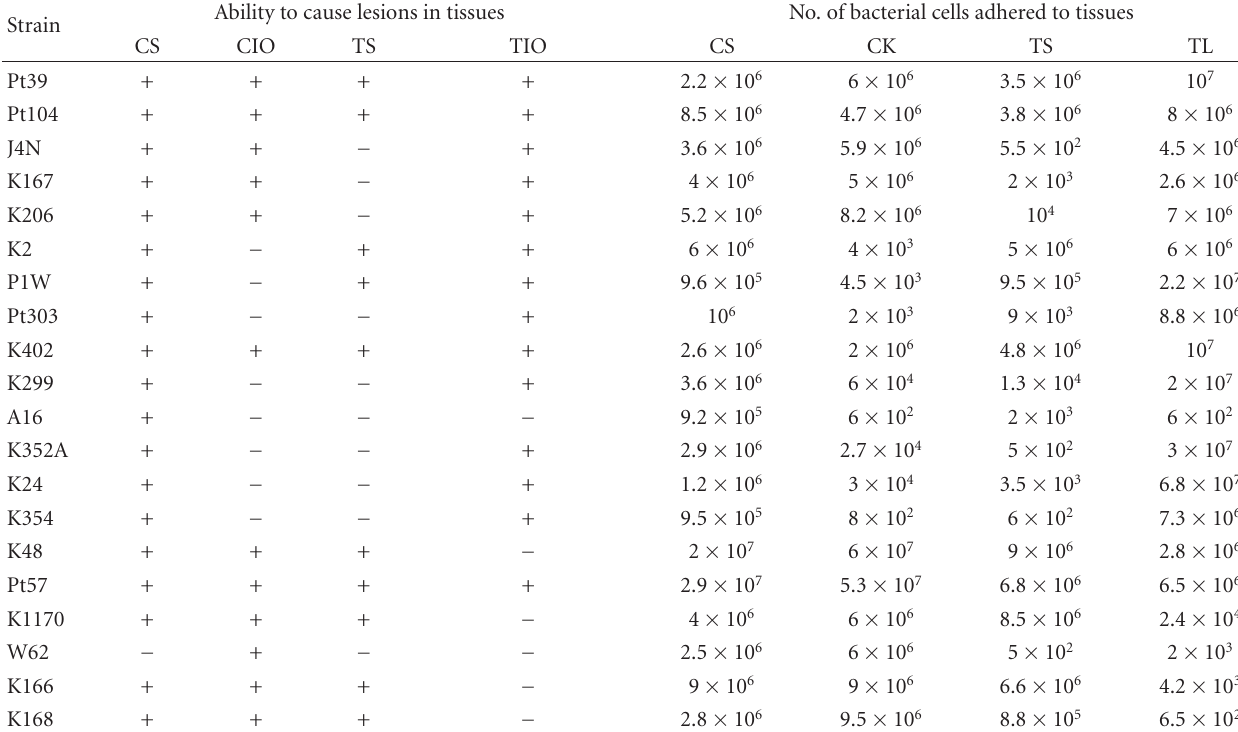
Table 4: The ability of Aeromonas strains to cause pathological lesions in carp and trout skin and internal organs in relation to their adhesion to these